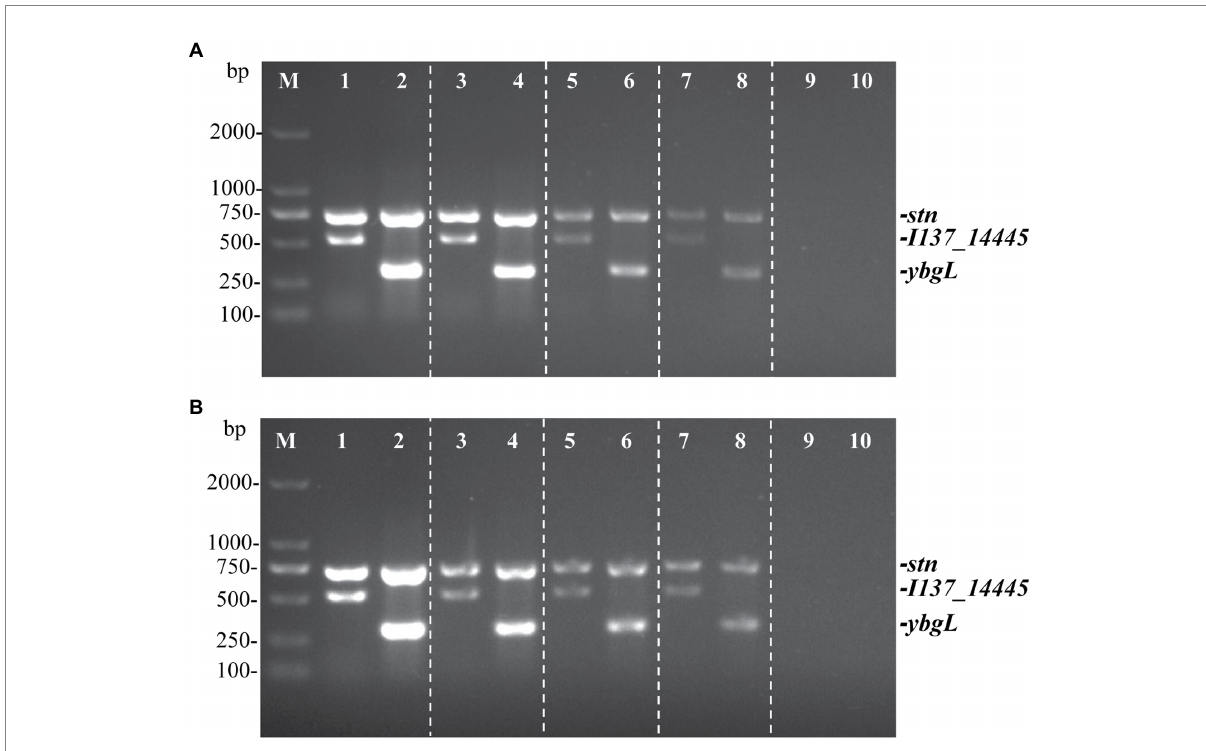
FIGURE 3 The multiplex PCR sensitivity to detect and differentiate S. Gallinarum (SG9) and S. Pullorum (S06004) with genomic DNA and cells. Three specific bands are amplified correlating with the stn (731 bp), I137_14445 (525 bp), and ybgL (307 bp) genes. The sensitivity of the multiplex PCR was determined to detect the genomic DNA (A) and Salmonella cells (B) . Lanes 1, 3, 5, 7, 9 ( S. Pullorum) and 2, 4, 6, 8, 10 ( S. Gallinarum). Different concentrations of genomic DNA were used: 21.4 ng/ μ L, 2.14 ng/ μ L, 214 pg./ μ L, 21.4 pg./ μ L, 2.14 pg./ μ L; bacterial cells were used as template at the following concentrations: 10 5 , 10 4 , 10 3 , 10 2 , 10 1